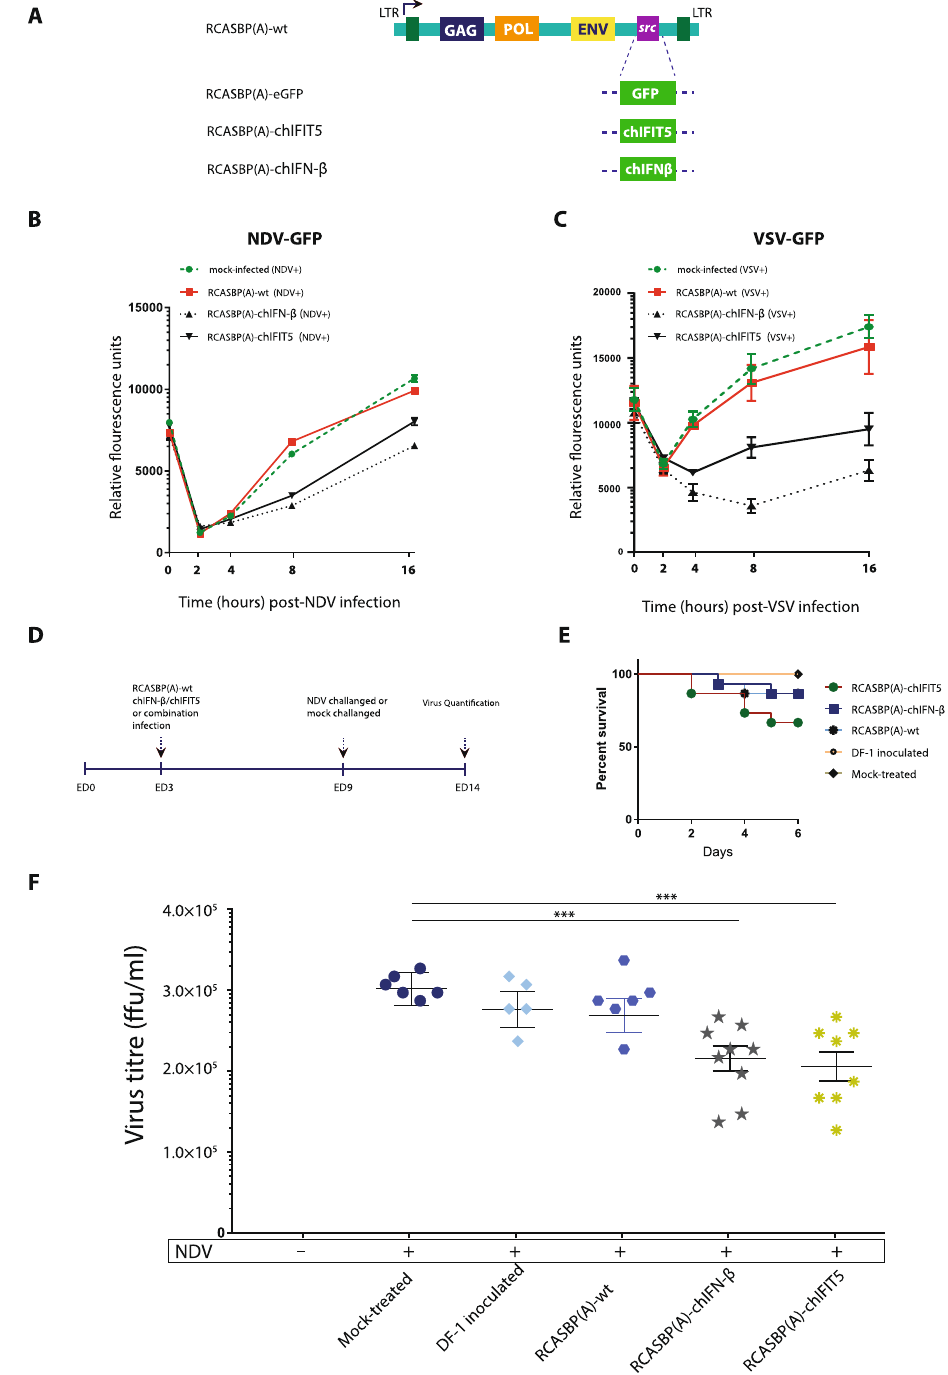
Figure 8. Generation of recombinant retroviruses and transgenic chicken embryos expressing marker gene (GFP), chIFN- β and chIFIT5, and their impacts on the replication of RNA viruses. ( A ) A schema for the generation of recombinant viruses in which src gene was replaced with either GFP, or chIFN- β or chIFIT5. ( B , C ) Stable DF-1 cells expressing chIFN- β (RCASA(BP)-chIFN- β ) or chIFIT5 (RCASA(BP)-chIFIT5), DF-1 infected with wt retroviruses (RCASA(BP)-wt) or non-infectious DF1 cells (mock-infected) were infected with NDV ( B ) or with VSV ( C ) and the replication of viruses were monitored until 16 hours post-infection and data are presented in relative fluorescence units compared to non-infected background. ( D ) Infectious cells that imparted antiviral effects were inoculated in 3 days old chicken embryos and allowed to develop until 9 days post-embryonation when 100 PFUs of NDV were inoculated per transgenic egg and the quantification of the virus replication was performed on day 14 post-embryonation. ( E ) Survival curve in retrovirus-infected or mock-treated chicken embryos. ( F ) Quantitative analysis of viruses in NDV infected and un-infected transgenic embryos expressing indicated transgene. Each dot represents individual chicken embryo in all